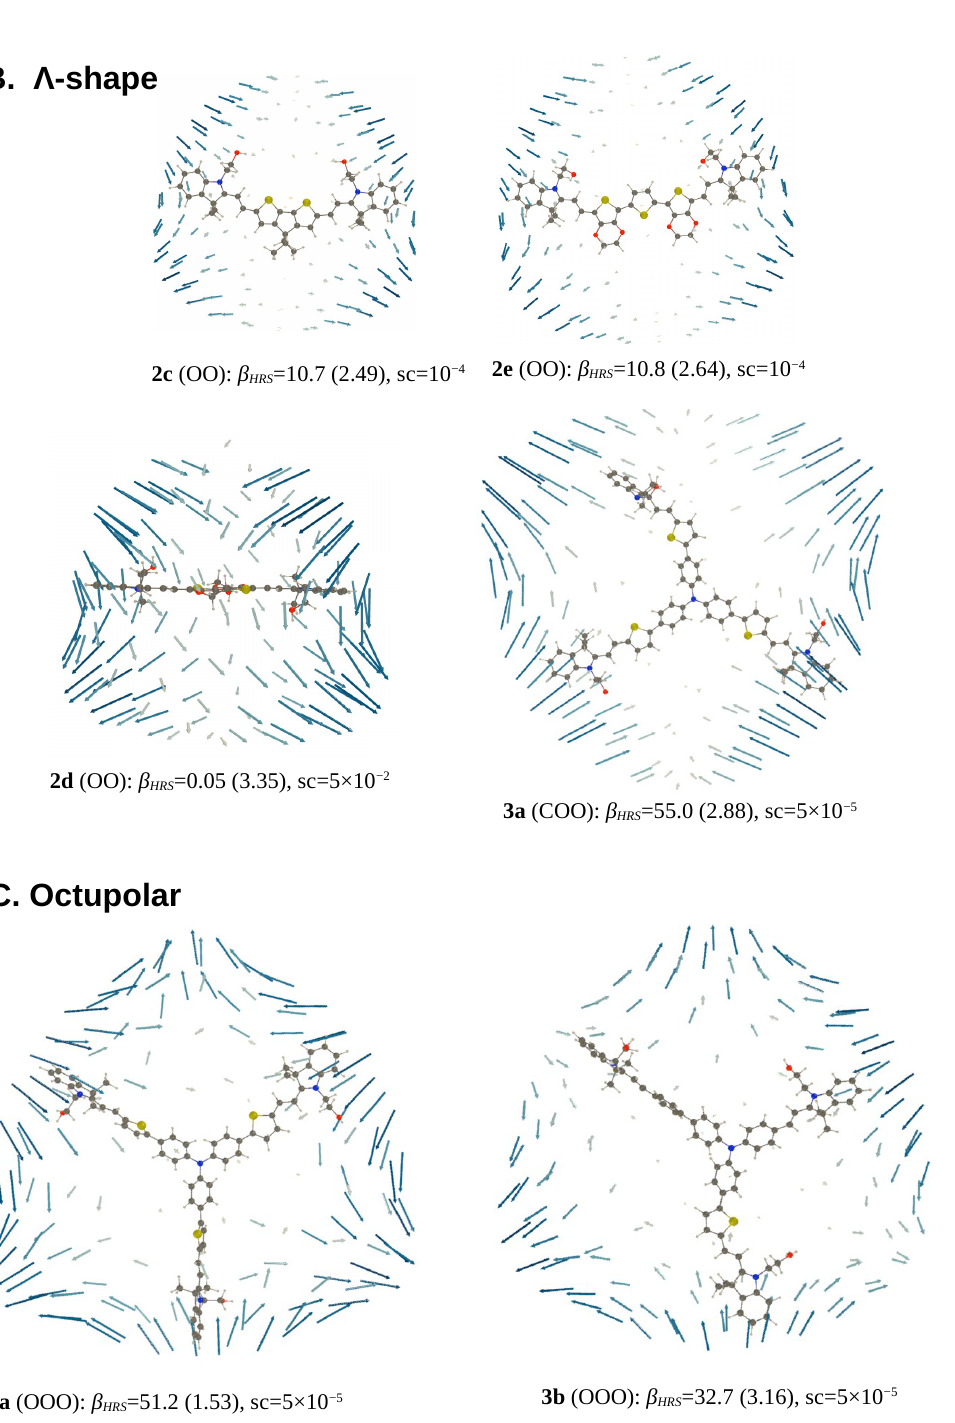
Figure 7. USR (together with β HRS (in 10 3 a.u., the DR in parentheses) and the scaling factor (sc, Åa.u. − 1 )) of the dynamic ( λ = 1907nm) β -tensor of the most stable conformers of selected dipolar (panel A), Λ -shaped (panel B) and octupolar (panel C) NLOphores, as evaluated at the TDDFT/M06- 2X/6-311+G(d)/IEF-PCM (acetonitrile) level of